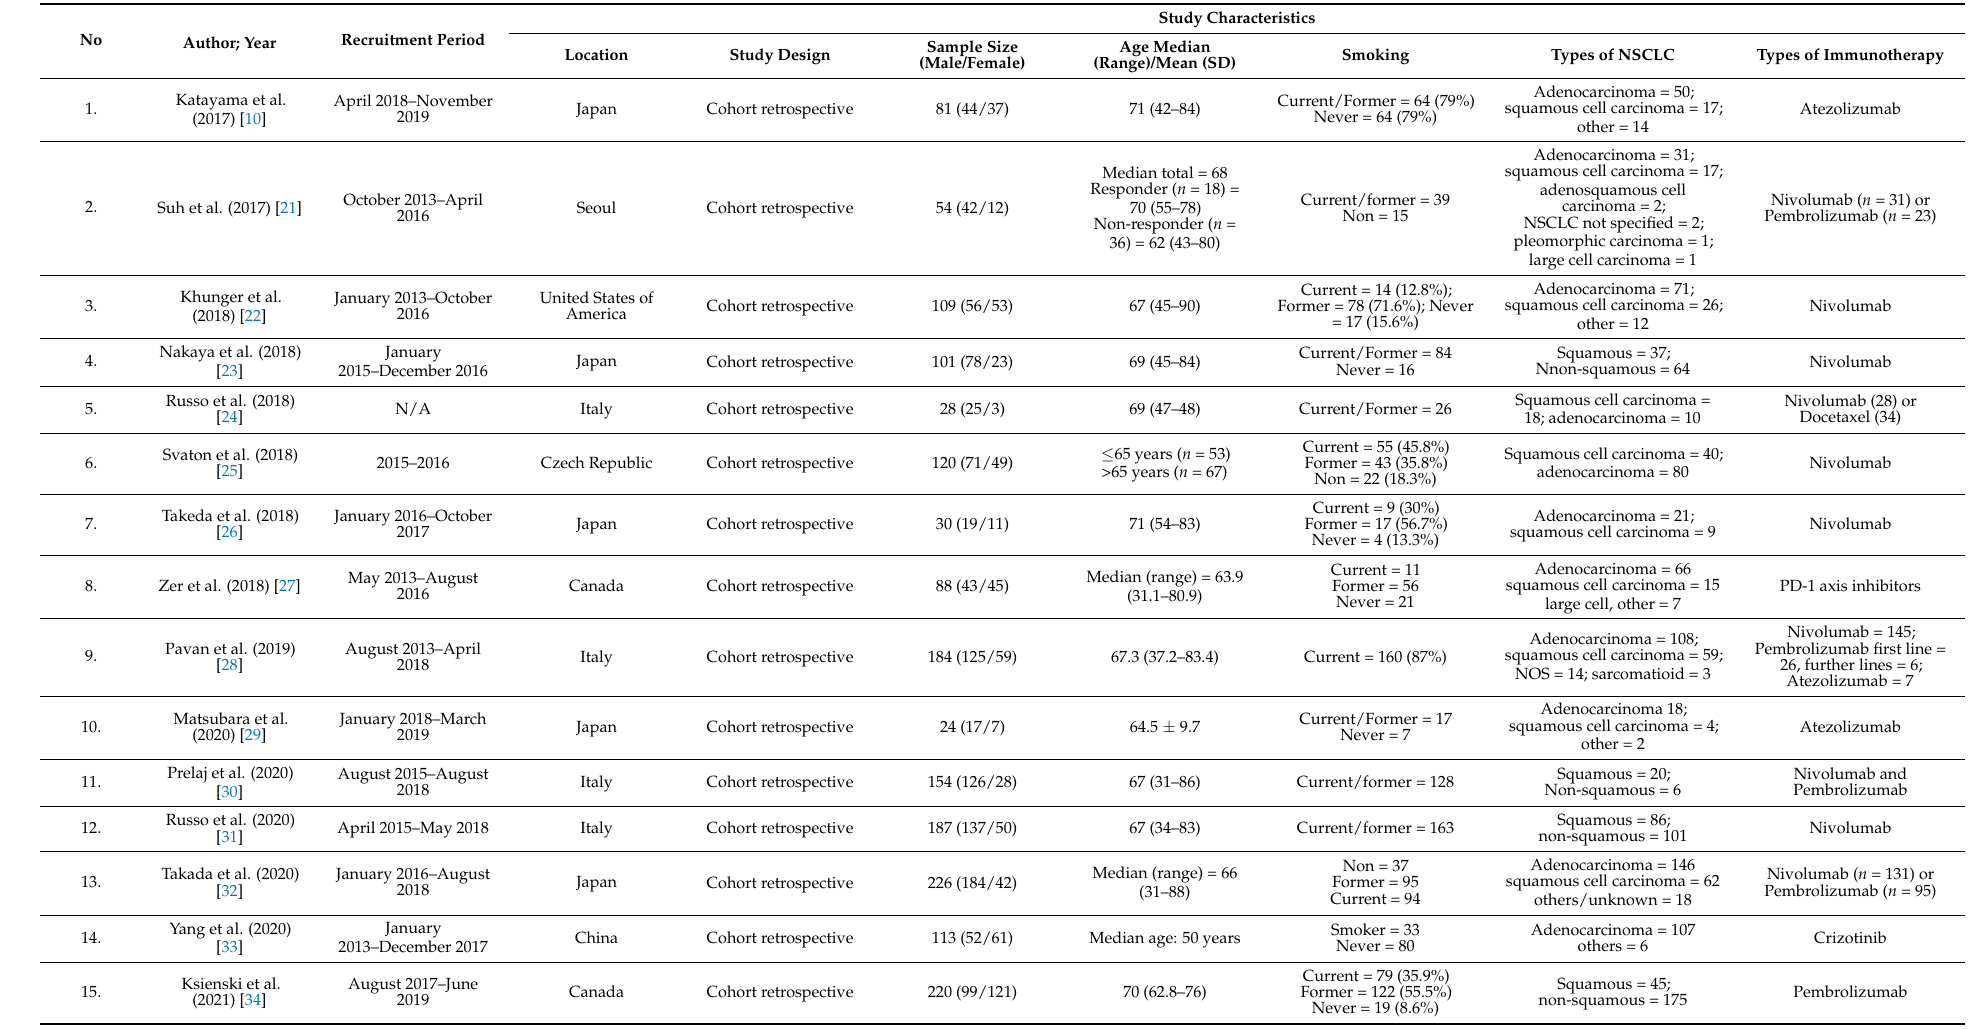
Table 1. Baseline characteristics of included